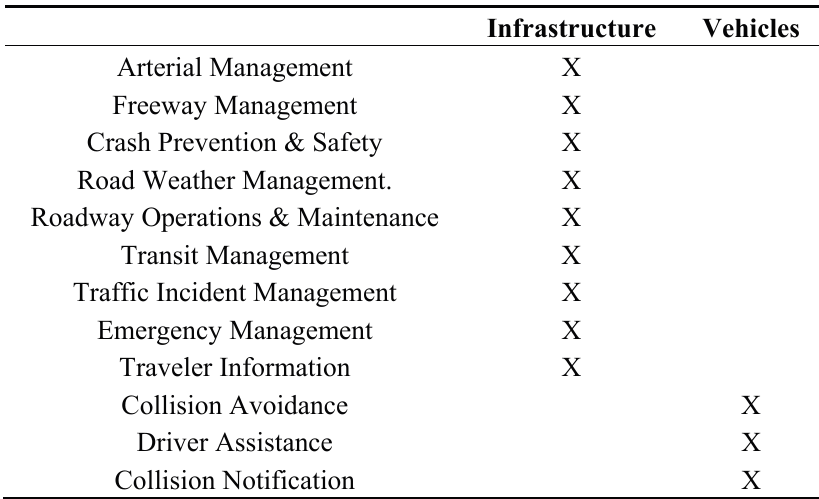
Table 1. ITS taxonomy provided by